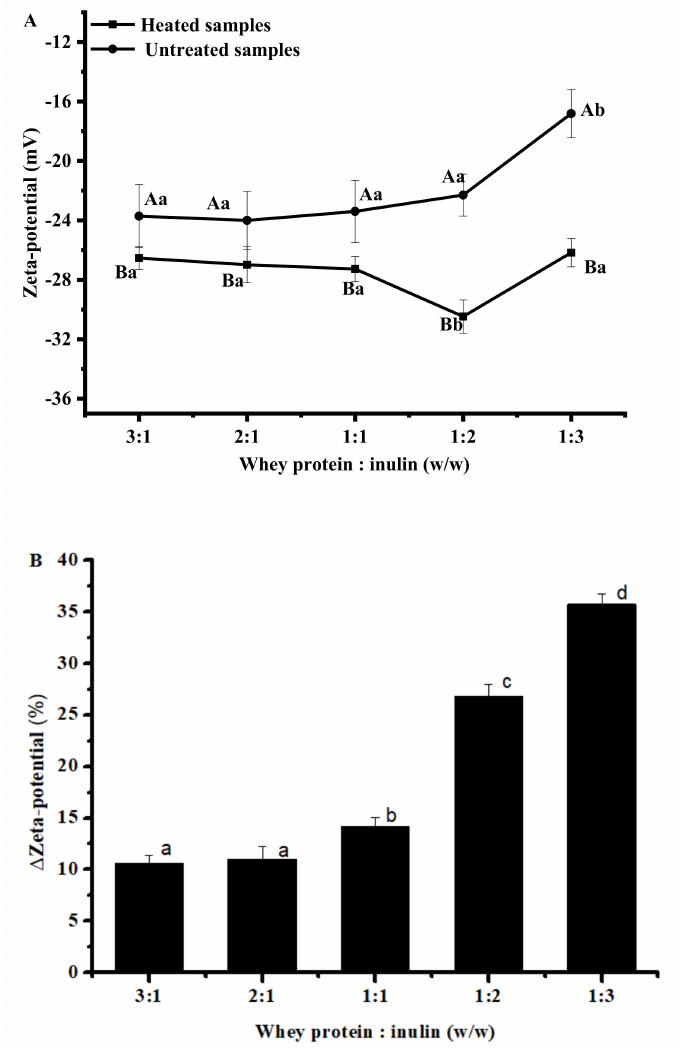
Figure 3. Zeta-potential of heated and untreated whey protein and inulin mixtures ( A ) and changes in zeta-potential of whey protein and inulin mixture after heating ( B ). Di ff erent lowercase letters denote significant di ff erence between samples at di ff erent ratios; Di ff erent uppercase letters denote significant di ff erence between untreated and dry-heated samples at same whey protein and inulin ratio. Error bars are ± SD of the